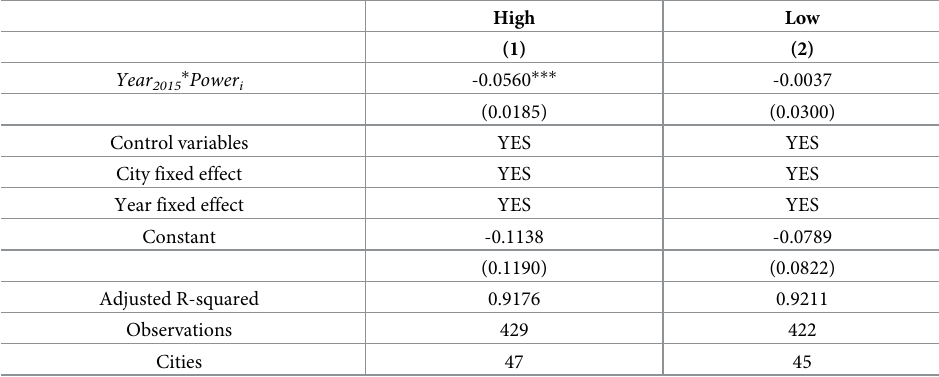
Table 13. Population size